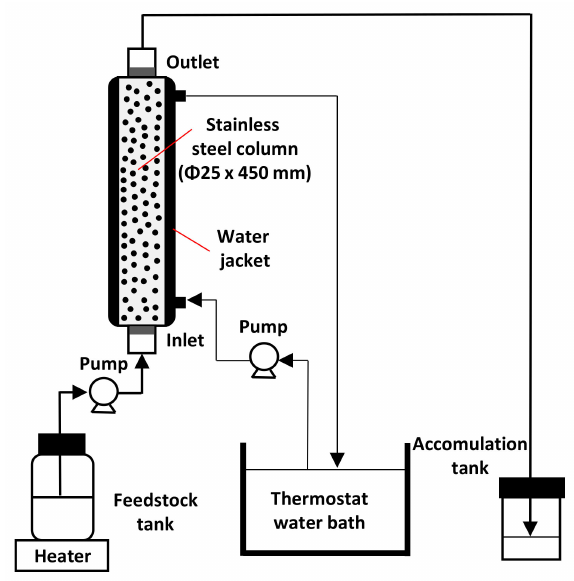
Figure 9. Fixed bed with high-pressure apparatus for deoxygenation reaction.